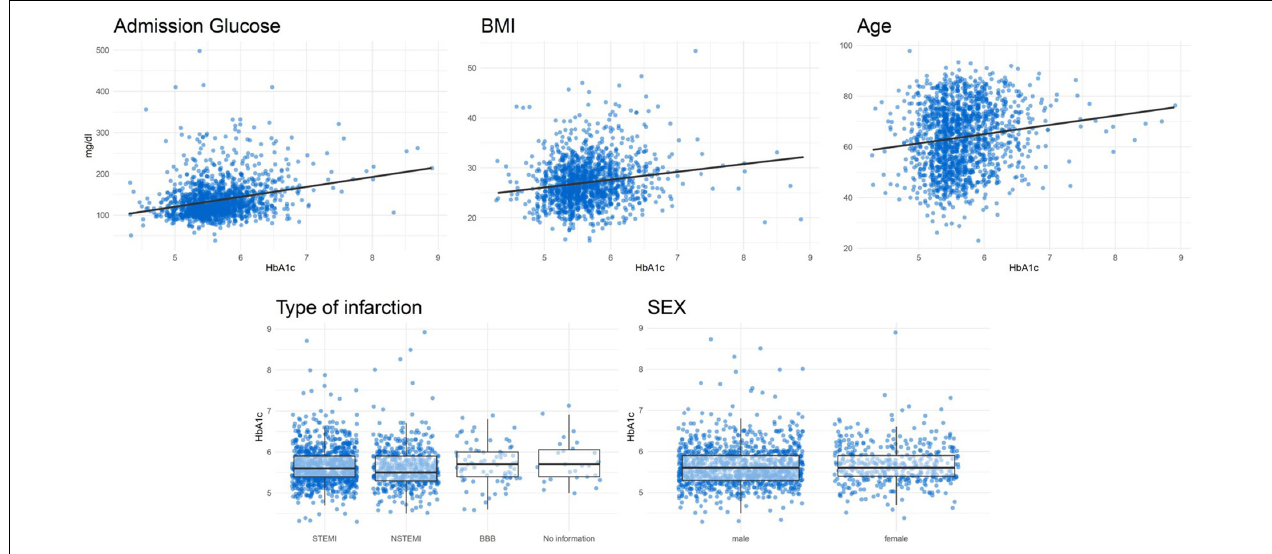
FIGURE 3 | Correlation plots between HbA1c and continuous variables and boxplots for categorical variables for patients without known diabetes.